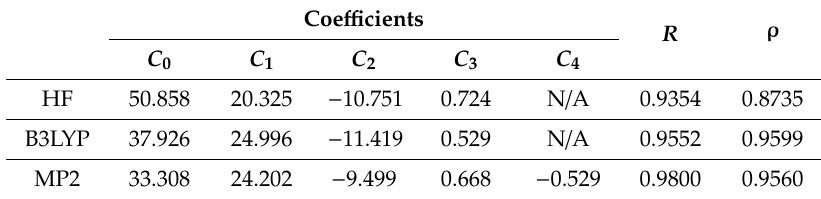
Table 3. Constants, coe ffi cients, and Pearson’s ( R ) and Spearman’s ( ρ ) correlation coe ffi cients for the PCB planarity prediction